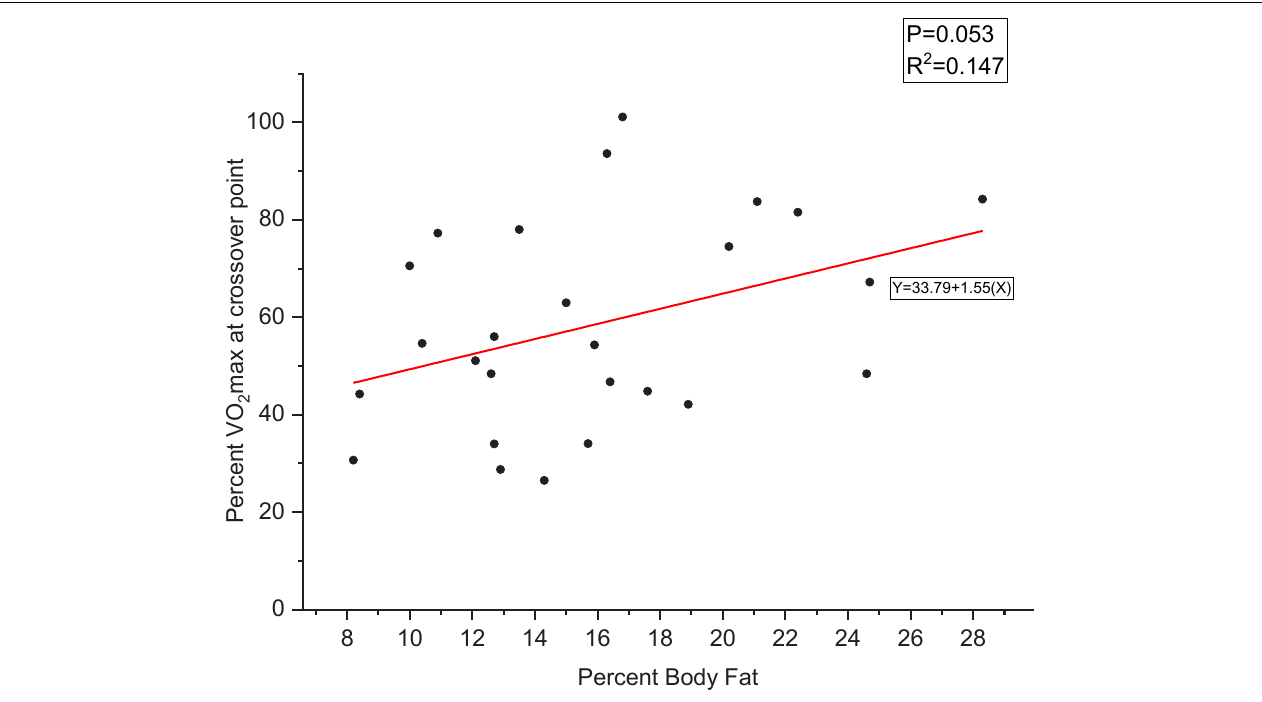
FIGURE 3 | Relationship between percent maximal oxygen consumption (VO 2 max) at crossover point and percent body fat during the submaximal graded exercise test (SGET). P = 0.053, there was a margin of statistical significance between a higher percent body fat and lipid utilization as the primary substrate (e.g., delays crossover to using carbohydrate). The red line is the regression line expressing the hypothesized relationship between percent VO 2 max at crossover point and percent body